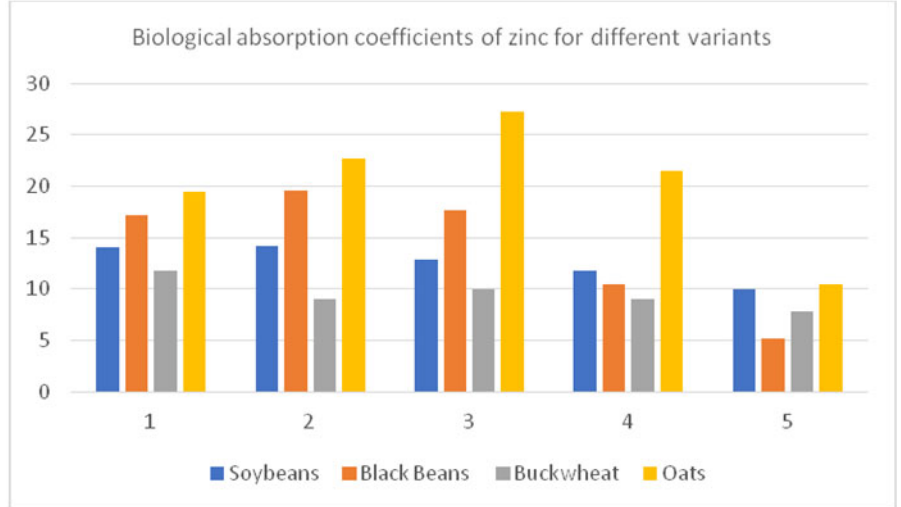
Figure 11. Values of coefficients of biological absorption A х (2) of lead at the different variants of the experiments (different total pollution index Zc ).